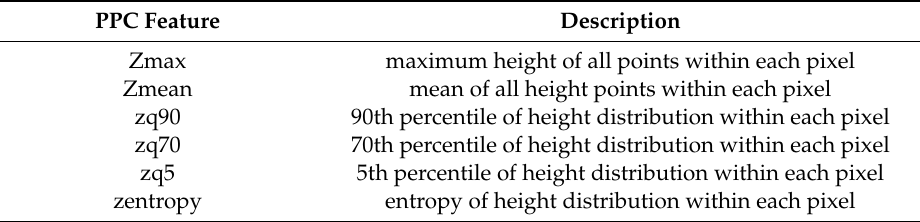
Table 5. Features extracted from the high density photogrammetric point